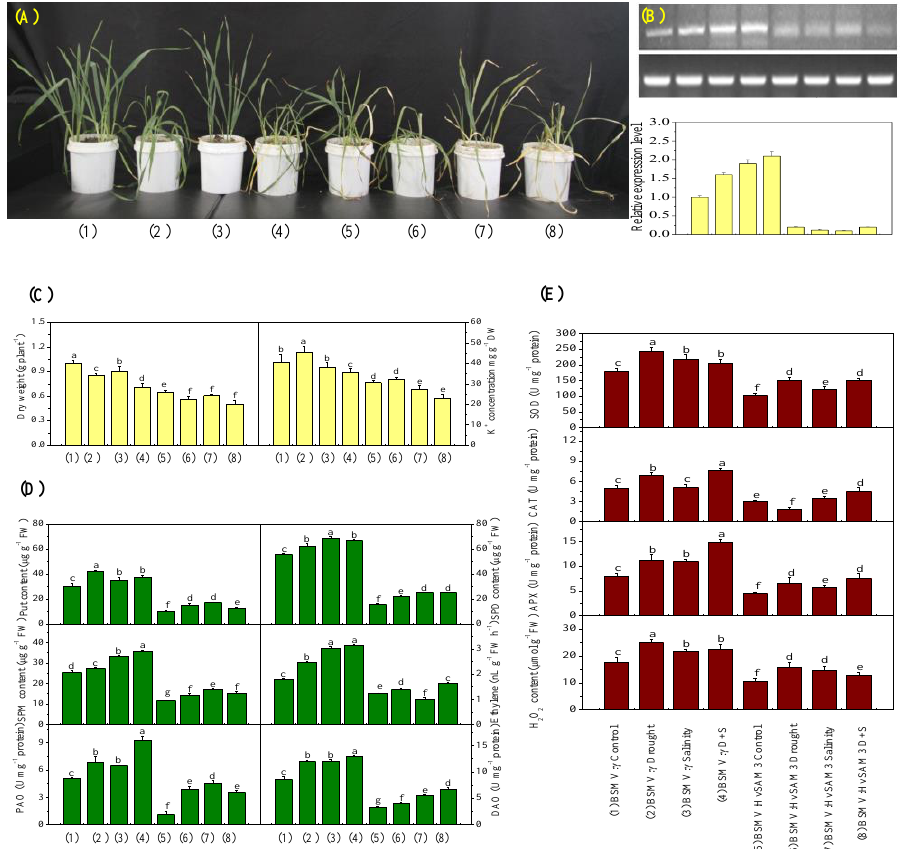
(1) (2 ) (3) (4) (5) (6) (7) (8)